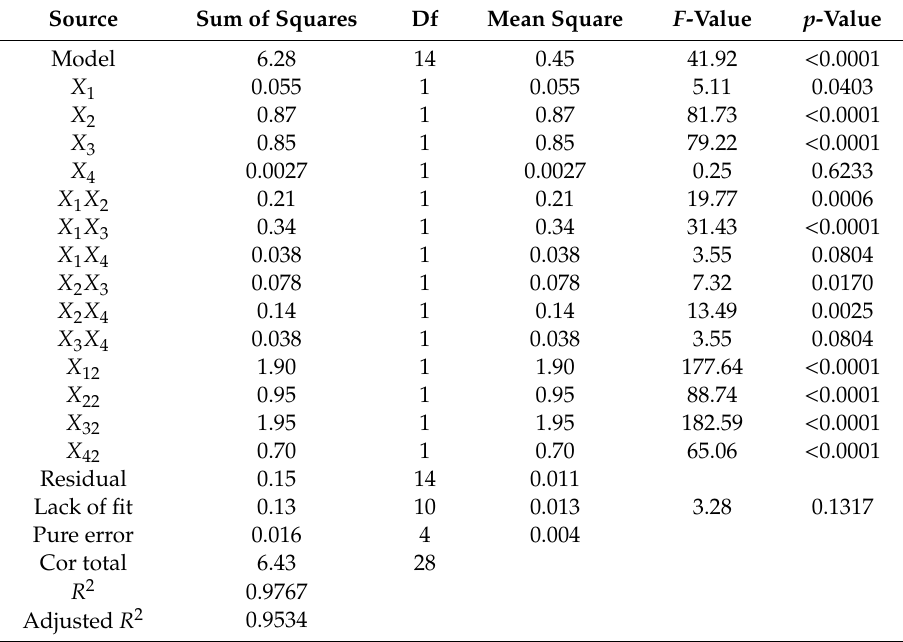
Table 2. The analysis of variance for the second-order polynomial